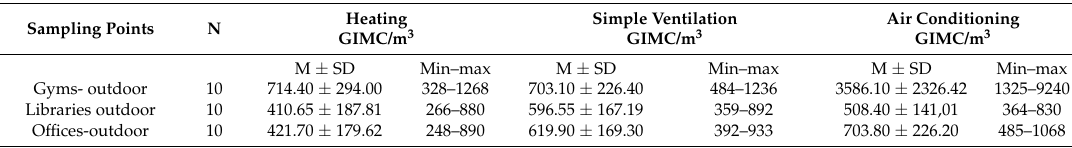
Table 7. GIMC/m 3 measured outside gyms, libraries, and offices during heating, air conditioning, and simple ventilation periods.